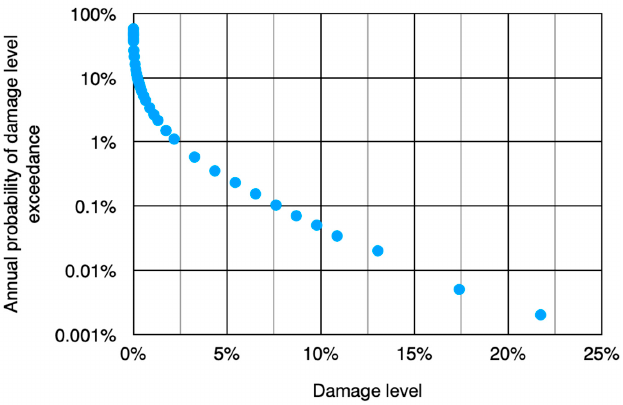
Figure 2. The empirical complimentary probability loss distribution function for the model 99 building portfolio of the Example, (Lee et al. 2021).